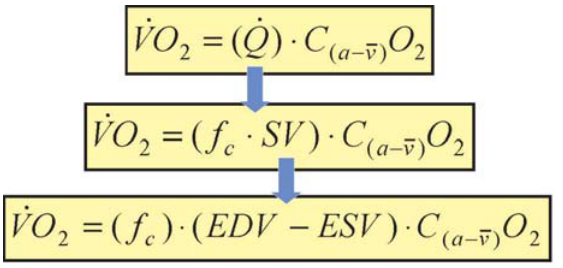
Figure 3 - The Fick equation for calculating oxygen uptake ( (cid:57) (cid:115) (cid:50) to text for detailed discussion. (cid:52) (cid:115) is cardiac output; C between the oxygen content of the arterial ( (cid:121) 20 ml of O of blood) and venous sides; f EDV is end-diastolic volume; and ESV is end-systolic